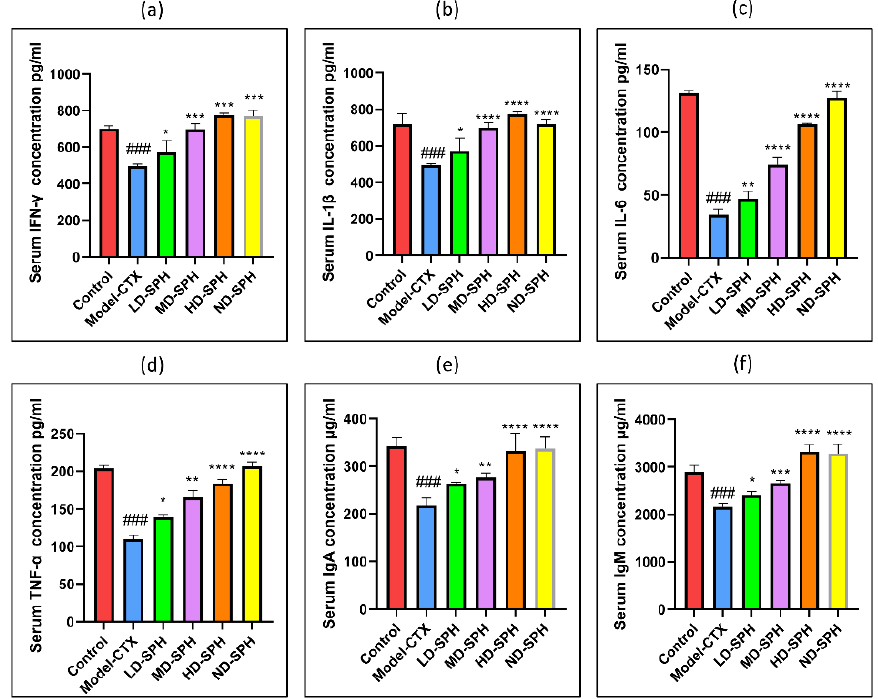
Figure 3. Effects of SPH on serum cytokines ( a ) IFN- γ , ( b ) IL-1 β , ( c ) IL-6, ( d ) TNF- α , and immunoglobulin concentration ( e ) IgA, and ( f ) IgM. ### p < 0.001 comparison to the Normal control group. * p < 0.05, ** p < 0.01, *** p < 0.001, and **** p < 0.0001, comparison to the Model-CTX group.